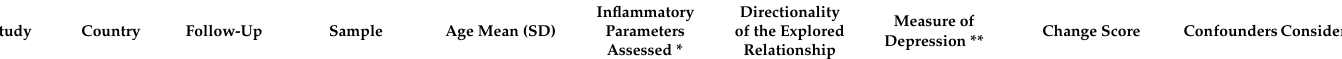
Table 1. Main characteristics of cohort studies included in the review.